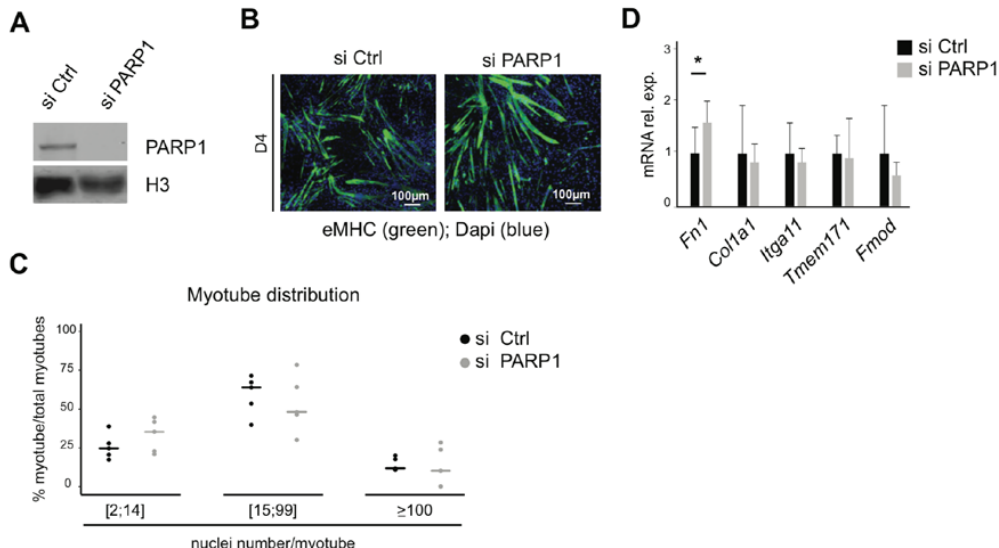
Figure 4. Silencing of PARP1 does not affect cell fusion or expression of fusion genes. ( A ) Successful PARP1 silencing by siRNA is shown by immunoblotting of C2C12 cells after four days of di ff erentiation. ( B ) Myotubes were analyzed by eMHC immunofluorescence in si Ctrl versus si PARP1 conditions at day 4. Nuclear DNA was stained by DAPI. ( C ) Percentage of myotube distribution divided into three groups, according to the range of nuclei per myotube. Data in C are the median of 600 myotubes from four distinct areas from three biological replicates, * p < 0.05, Student’s t -test. ( D ) Relative mRNA levels of five fusion genes (identified in Figure 3) in si Ctrl and si PARP1 conditions. Data in D are the mean of four independent experiments + SD; * p < 0.05; Student’s t -test.